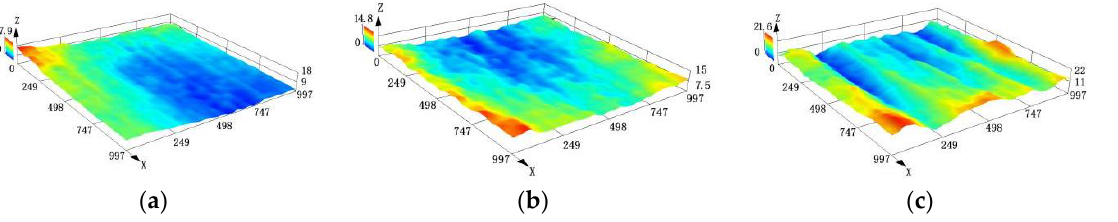
Figure 3. Three-dimensional view of the surface morphology of sample No. 5. ( a ) cutting-in area; ( b ) middle area; ( c ) cutting-out area.